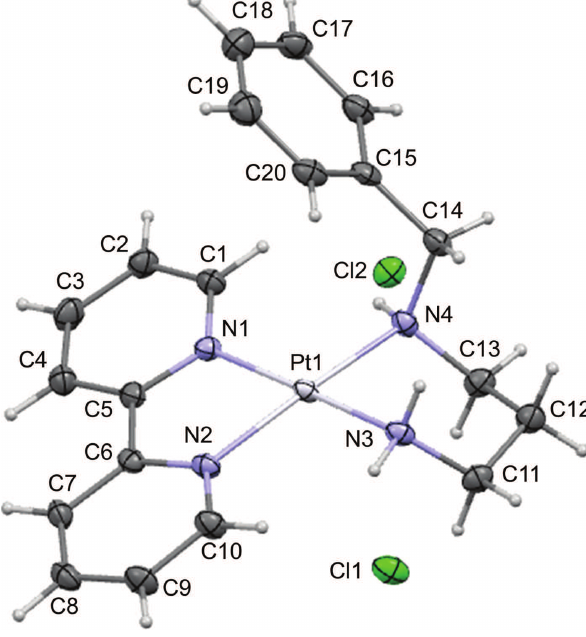
Table 1: Data collection and